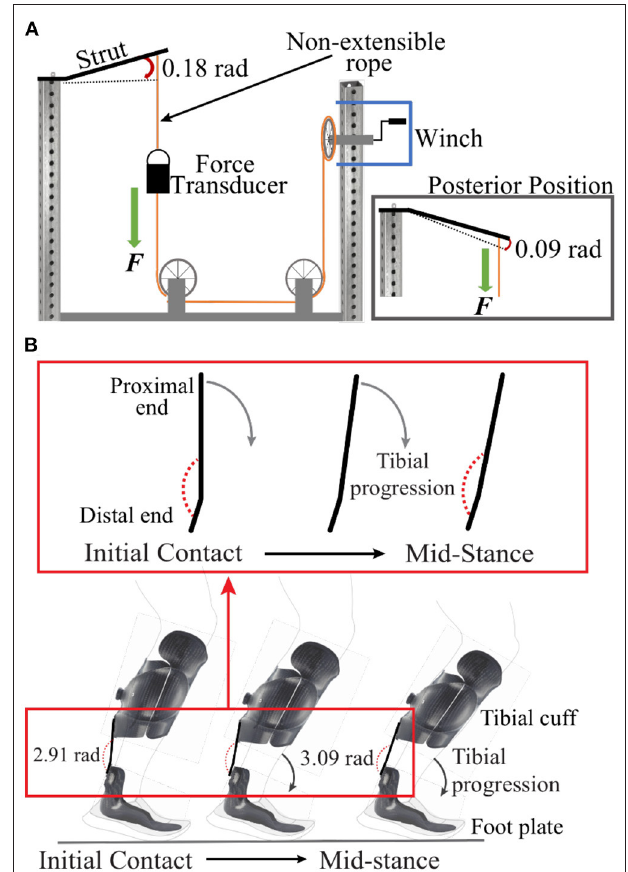
FIGURE 1 | (A) Illustration of the custom bending apparatus. During testing, the distal end of each IDEO strut was rigidly secured to a steel frame and force was applied to the proximal end of the strut using a non-extensible rope and hand cranked winch. A force transducer was placed in-line with the non-extensible rope. We applied force to deflect the strut by 0.18rad (10 ◦ ) in the anterior direction (pictured) and 0.09rad (5 ◦ ) in the posterior direction by re-attaching the distal end of the strut to the frame (inset). For posterior deflection, we removed the strut and flipped it so that the rope was attached to the opposite surface and was parallel to the attachment point for anterior deflection. (B) Illustration of the anterior deflection (0.18rad) of the IDEO strut during the stance phase of running, from initial contact to mid-stance. When no force is applied, the angle between the proximal and distal end of the IDEO strut is 2.89rad (165 ◦ ). As the tibial cuff rotates over the footplate during the first half of stance, the proximal end of the strut and tibial cuff rotate forward and the angle between the proximal and distal end of the strut increases by ∼ 0.18rad (10 ◦ ).